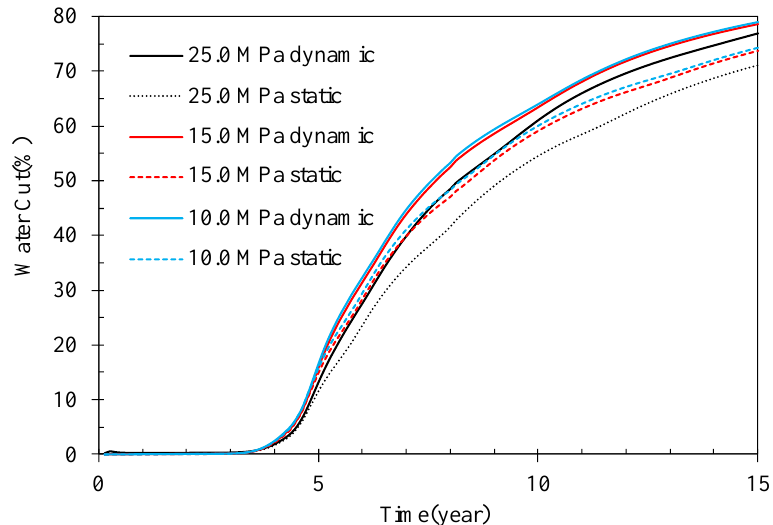
Figure 5. Water cut under different formation pressures.